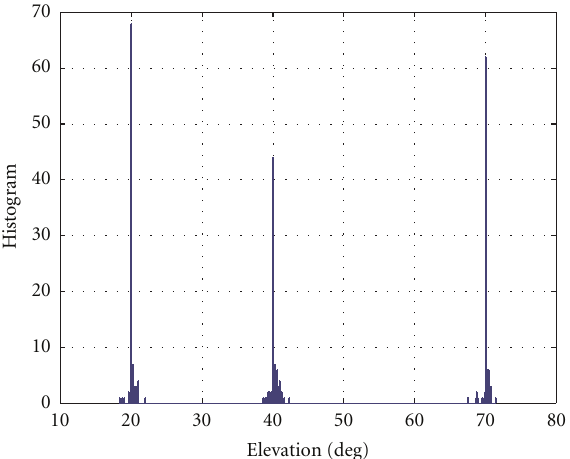
Figure 11: Histogram plot of estimated elevation angles using ESPRIT algorithm after applying proposed compensation.